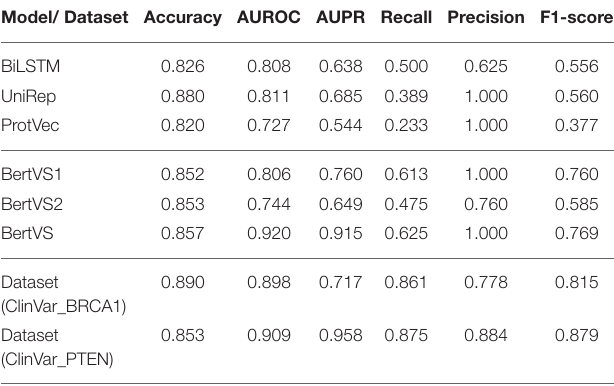
TABLE 3 | The comparison results of all models on BRCA1 and PTEN